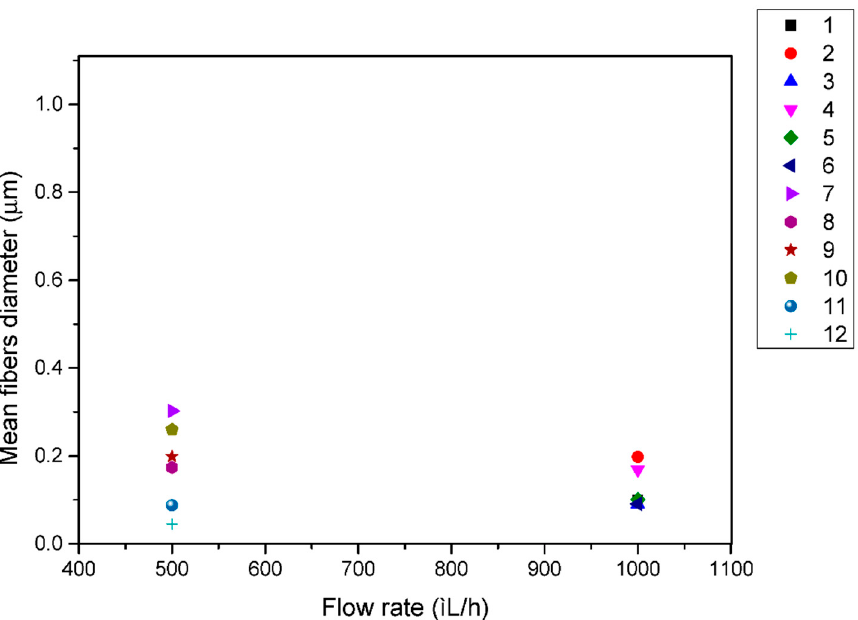
Figure 4. Effect of the flow rate on the fibers diameter ( µ m) for PCL (Mn 70,976) from 17% w / v chloroform solution for each investigated system of parameters.